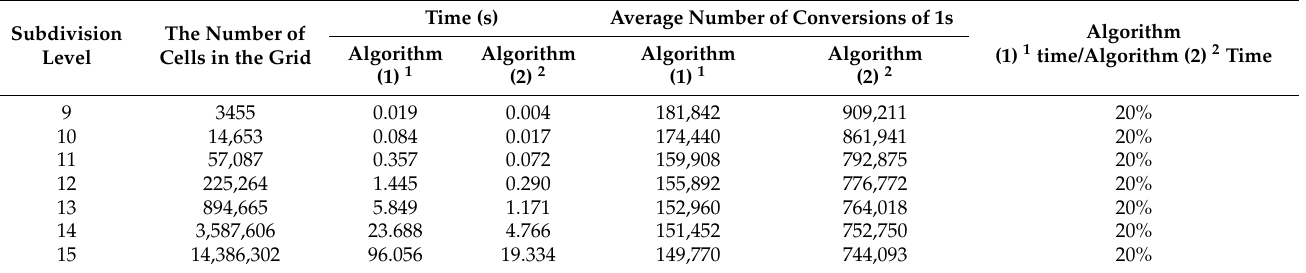
Table 7. Comparison table of the algorithms efficiency of conversion from Goodchild encoding to LS